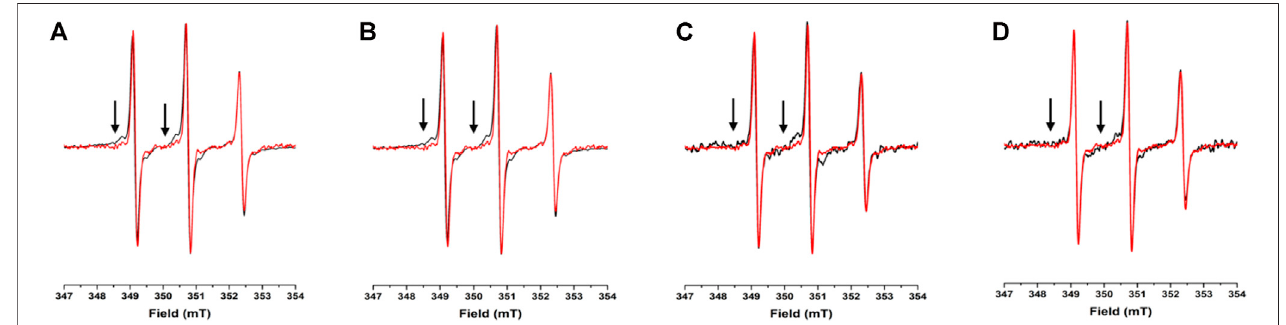
FIGURE 2 | EPR spectra under different conditions for A2C-MTSL : X-band CW-EPR spectra at room temperature of the A2C-MTSL mutant in buffer (red) and in presence of crowders (black): Ficoll-70 at 50 mg/ml (A) and 150 mg/ml (B) , Dextran-40 at 50 mg/ml (C) and 150 mg/ml (D) .